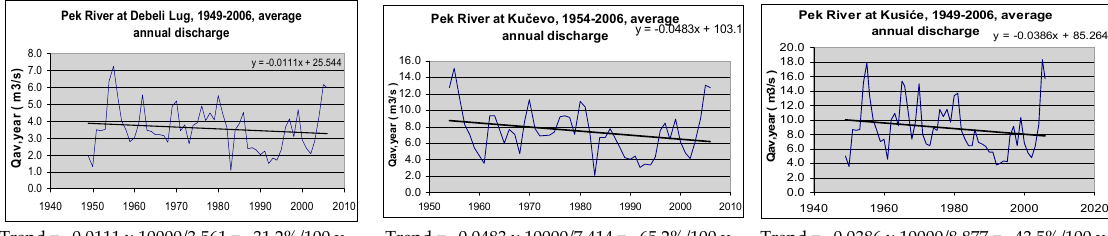
Figure 2. Observed annual trends at the three hydrological stations on the Pek